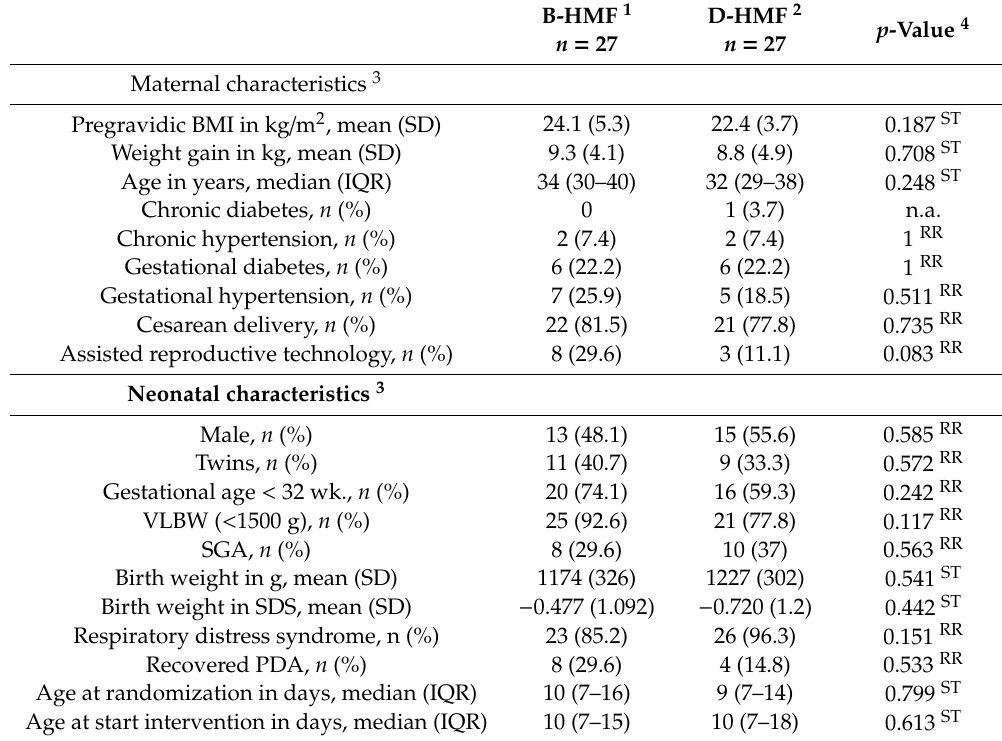
Table 1. Maternal and neonatal characteristics and clinical conditions at